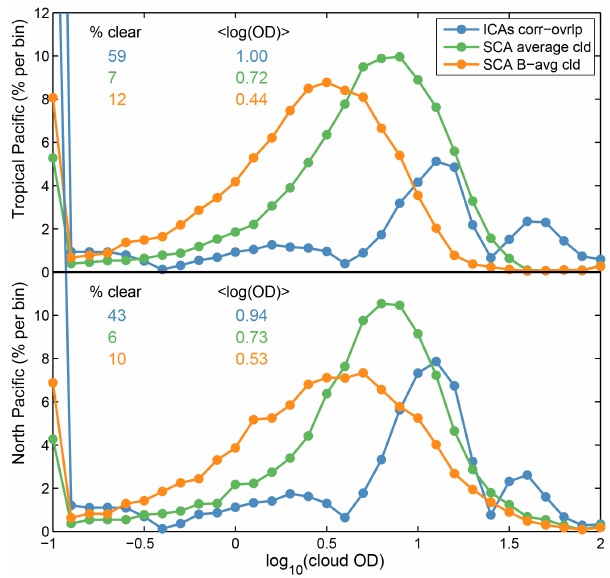
Figure 6. Histogram (% per 0.1 bin) in log of the total cloud optical depth (COD) based on method of implementing fractional clouds: Cloud- J independent column atmospheres (ICAs, blue dots); sim- ple cloud averaging over each cell (COD × CF, green dots) and B-averaging (COD × CF 3 / 2 , orange dots). The 600nm COD for two large regions (tropical Pacific, 20 ◦ S–20 ◦ N × 160–240 ◦ E, and North Pacific, 20–50 ◦ N × 170–225 ◦ E. is collected for 16 Au- gust 2016 from eight 3h averages of COD and cloud fraction (CF) in each model layer. The “% clear” is the sum of fractions (%) with log 10 (total COD)< − 0 . 5; and the “<log(OD)>” is the average of log 10 (total COD)> − 0 . 5. The cloud fields come from the ECMWF IFS cycle 38 system run at T159L60N160 resolution. On average the number of ICAs per cell in the tropical block is about 170, al- though individual cells may have >1000. In spite of the high, 40– 60% fraction of clear columns, the quadrature-averaged J values usually include some cloudy